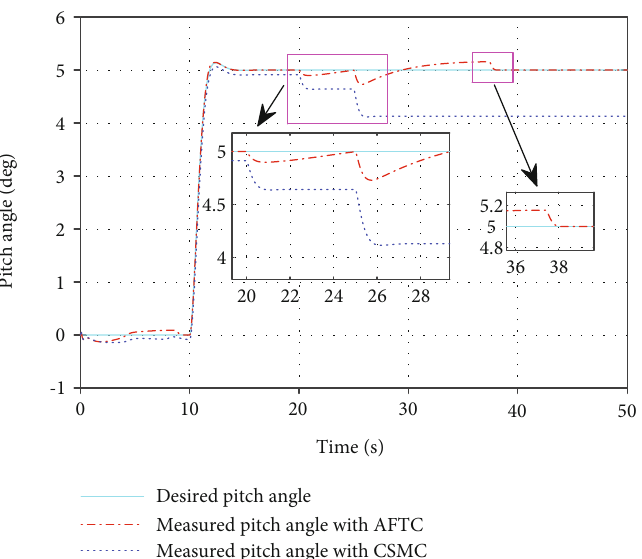
Figure 7: Pitch motion tracking performance of the UAV in the presence of concurrent elevator and canard control surface faults in scenario 2.